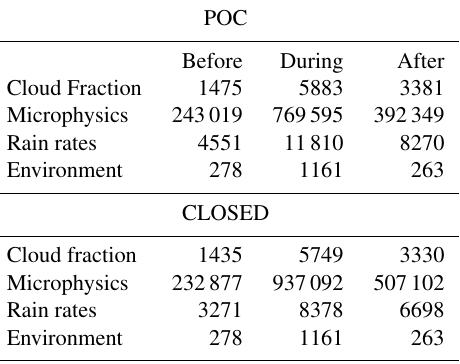
Table 2. The number of daytime samples for GOES-16 cloud frac- tion, GOES-16 microphysics (cloud optical depth, liquid water path, cloud-top effective radius, and cloud drop number concentration), and Advanced Microwave Scanning Radiometer 2 rain rates is